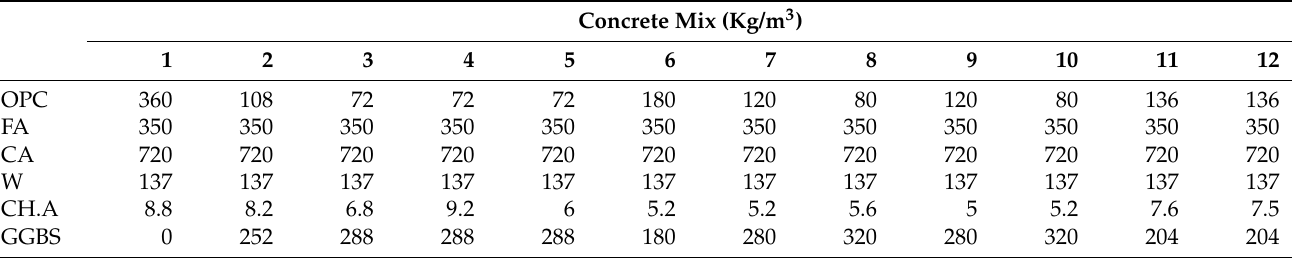
Table 10. Concrete mix optimisation extracted from